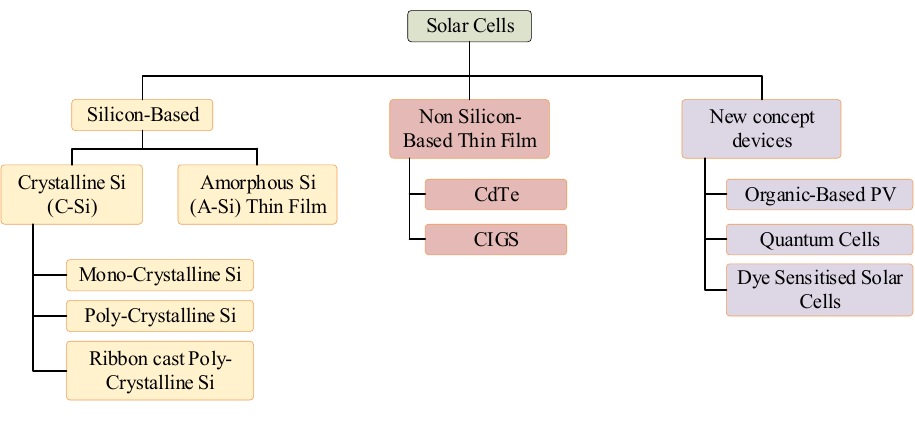
Figure 2. PV Technologies